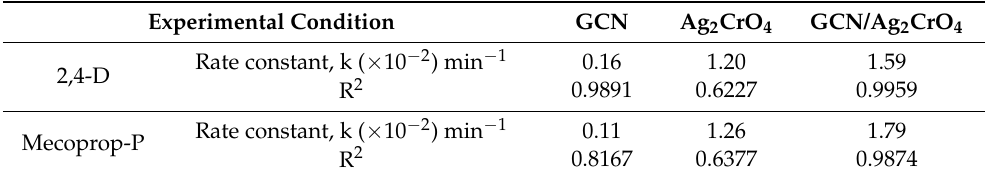
Table 1. Summary of first-order photocatalytic degradation rate constants.